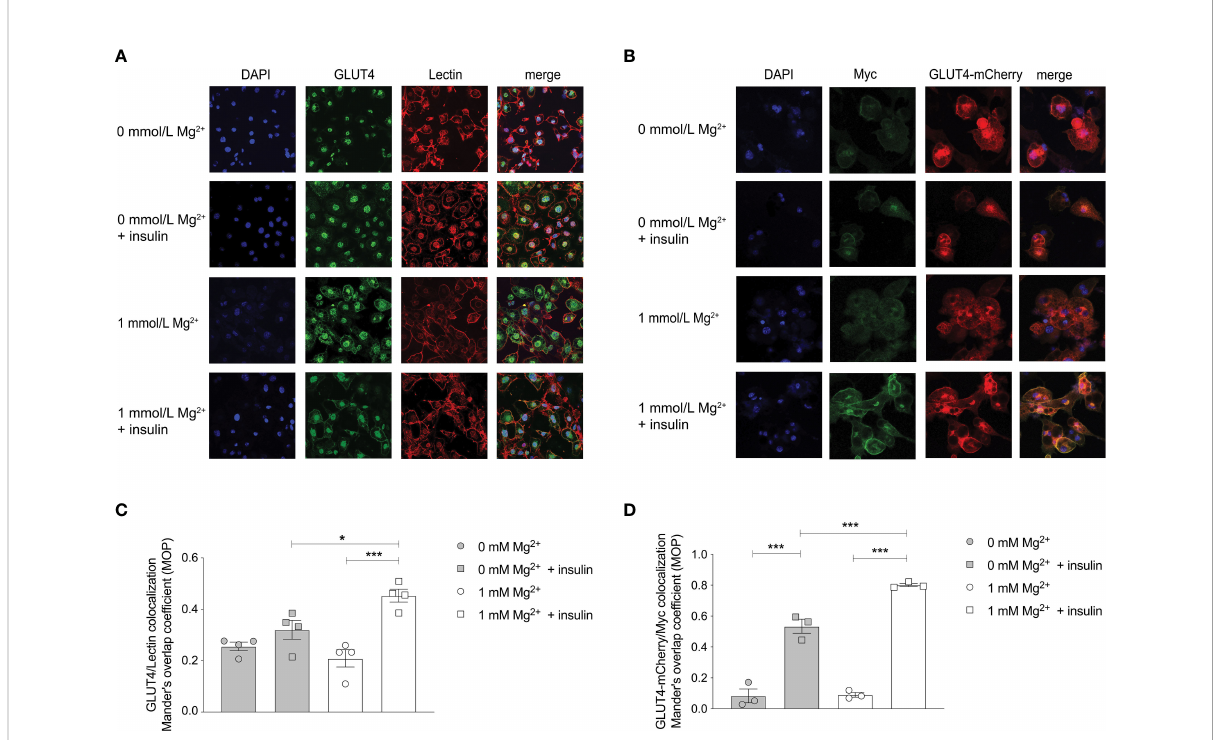
FIGURE 3 Effect of Mg 2+ on insulin-dependent localization of the GLUT4 transporter to the cell membrane in 3T3-L1 adipocytes. (A) Immunocytochemistry staining of DAPI, GLUT4 and the cell membrane marker Lectin in insulin-stimulated 3T3-L1 adipocytes that are incubated with 0 or 1 mmol/L Mg 2+ (n=4). GLUT4 signal was assessed at the plasma membrane, since GLUT4 antibody did result in non-speci fi c nuclear staining. (B) Immunocytochemistry staining of DAPI, anti-myc and GLUT4-mCherry in insulin-stimulated 3T3-L1 adipocytes that were transduced with pLenti-Myc-GLUT4-mCherry, incubated 0 or 1 mmol/L Mg 2+ (n=3). (C) Quanti fi cation of the immunocytochemistry staining by co-localization GLUT4 and Lectin at the plasma membrane compared to total cytosol expression (n=4). (D) Quanti fi cation of the ratio of cell surface Myc signal to total mCherry signal in 3T3-L1 adipocytes transduced with pLenti-myc-GLUT4-mCherry (n=3). Legend: circle is without insulin, square is with insulin, grey color is 0 mmol/L Mg 2+ and white color is 1 mmol/L Mg 2+ . Data are shown as mean ± S.E.M. Statistically analyzed with Two-Way ANOVA. Signi fi cance *p<0.05; ***p< 0.001. GLUT4, glucose transporter 4; Mg 2+ ,